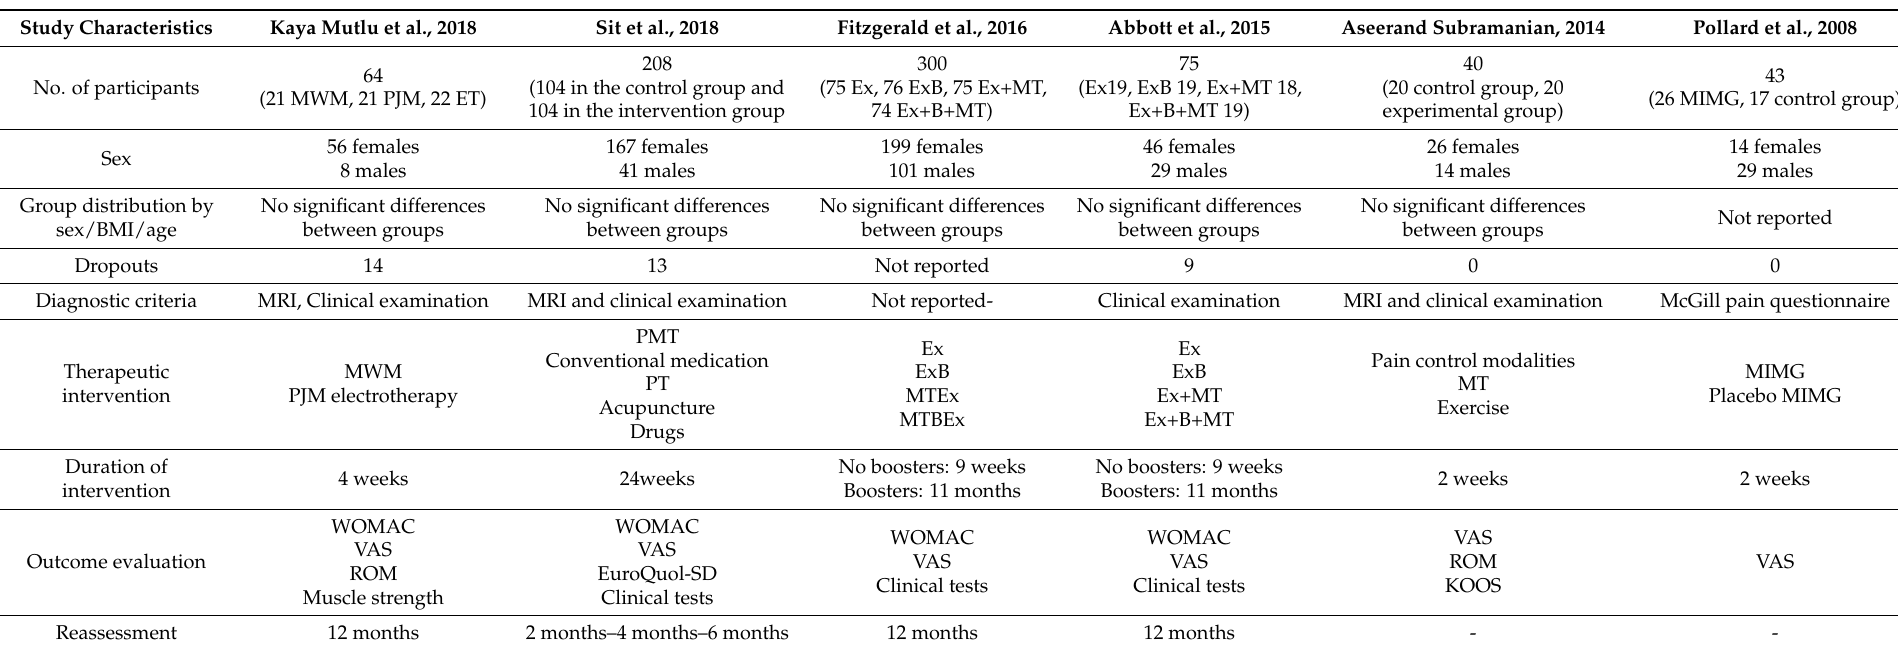
Table 2. Characteristics of the included